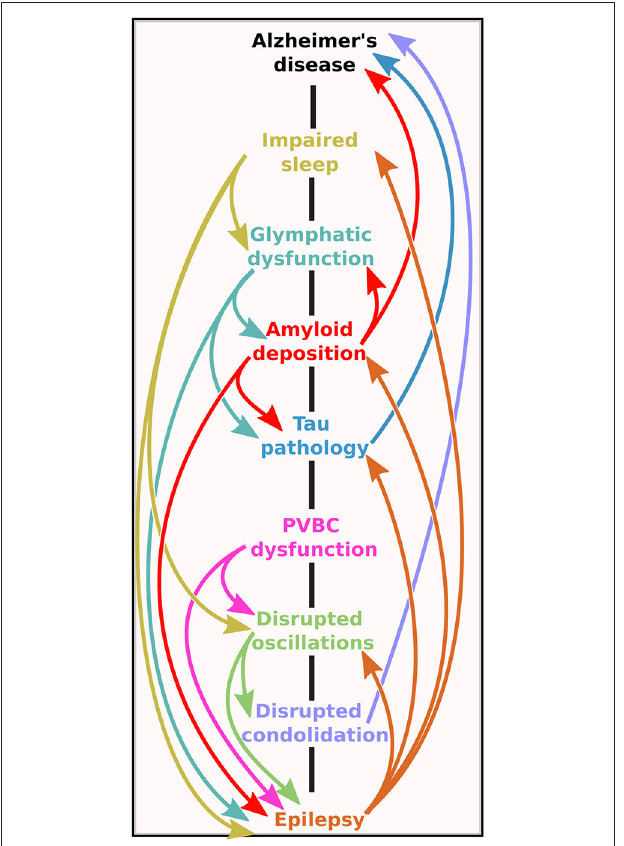
FIGURE 4 | The bidirectional road between Alzheimer’s disease and epilepsy. Note that the mechanistic pathways contain several vicious cycles, meaning that no matter at which level the initial imbalance is on the road, the self-amplifying potential of the system could lead to the onset of one (or possibly both)